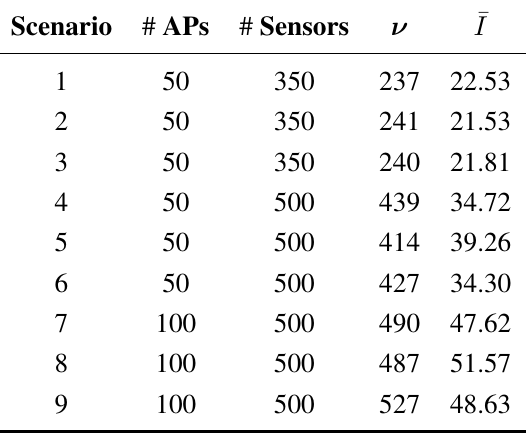
Table 1. Summary of